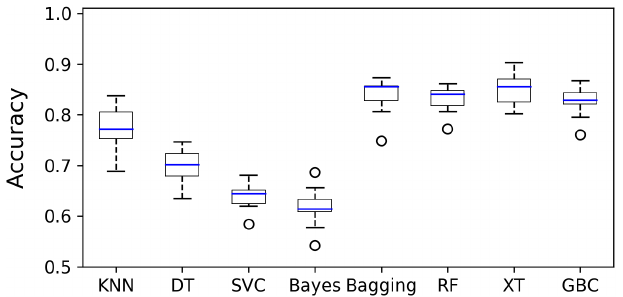
FIG. 7. Boxplots showing accuracy scores from a tenfold cross- validation analysis of several algorithms for cavity fault classi- fication. The blue line denotes the median, the box spans the interquartile range (IQR), and the upper (lower) whiskers indicate values 1 . 5 × IQR above (below) the upper (lower) box boundary, with data beyond the whiskers represented as open markers. Ensemble models (four rightmost boxplots) exhibit the best